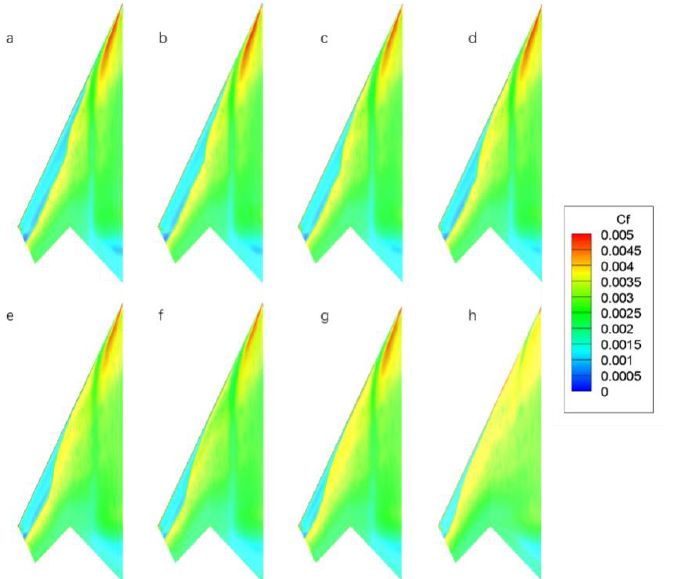
Figure 11. Friction coefficient distributions on the lower surface of the flying wing model with dif- ferent turbulence levels ( M = 0.9, α = 2°, Re = 10 × 10 6 ): ( a ) T u = 0.05%; ( b ) T u = 0.1%; ( c ) T u = 0.2%; ( d ) T u = 0.3%; ( e ) T u = 0.4%; ( f ) T u = 0. 5%; ( g ) T u = 0.6%; ( h ) T u = 0.7%.